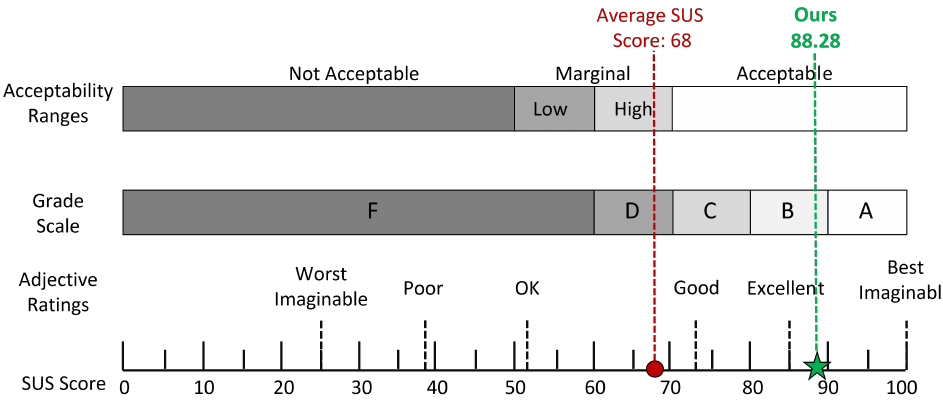
Figure 11. SUS score results for the proposed pixel avatar method.